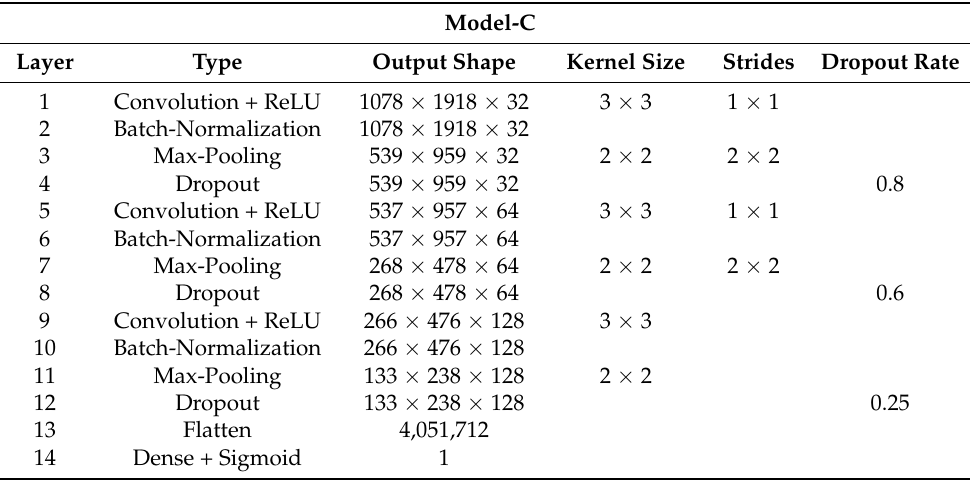
Figure 4. Proposed CNN architecture of Model-C for detecting deepfake images. Table 3. Summary of self- developed CNN network: Model-C for DFDC image